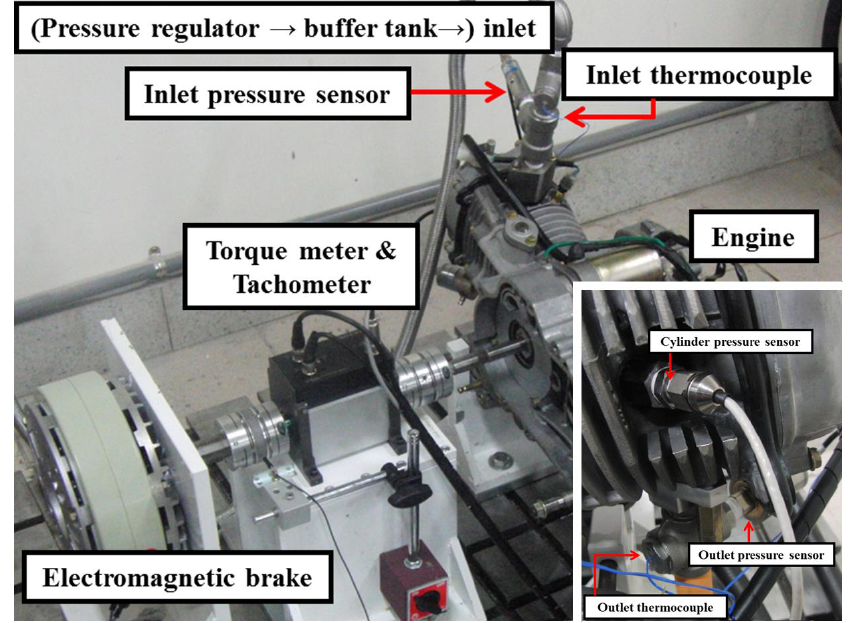
Figure 2. Photograph of the experimental compressed air engine